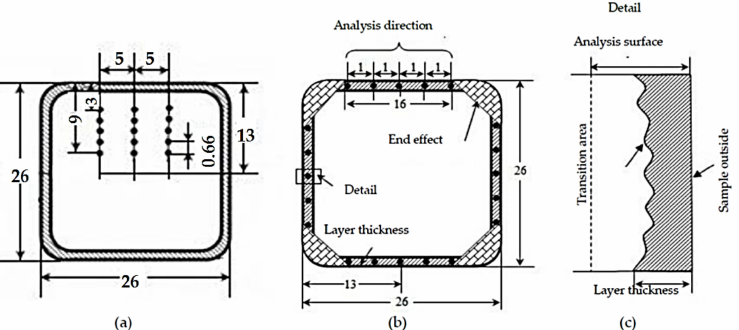
Figure 2. The analysis procedure to evaluate the structure parameters (graphite and metal matrix) in the casting body ( a ) and in the surface layer and skin (surface layer) thickness ( b , c ) (Units-mm). Figure 2b,c shows the procedure of structure analysis on the section of the surface